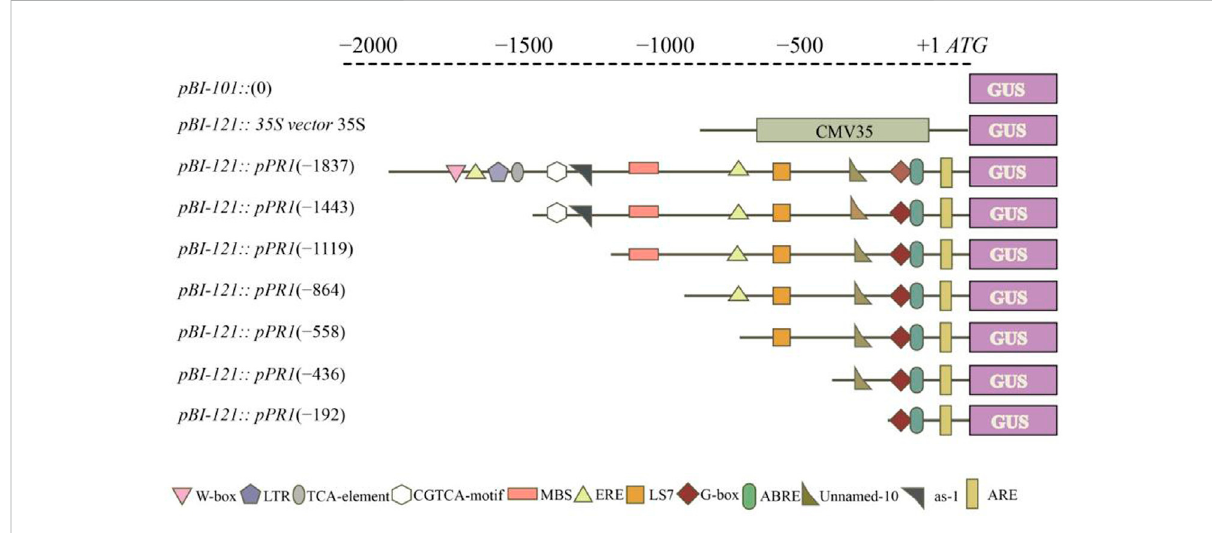
FIGURE 1 Schematicrepresentation of the VvPR1 promoter. Constructs for assaying GUS ( β -glucuronidase) expression in tobacco leaves. The constructs of serially deleted promoter fragments of the VdPR1 gene were fused to the GUS reporter gene in the vector pBI-121